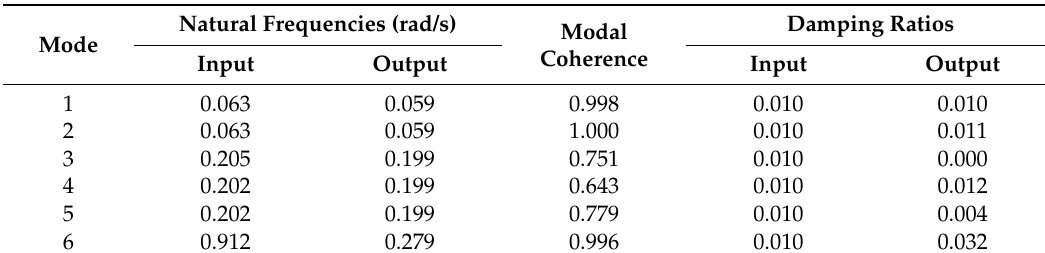
Table 10. Evaluation of FDD efficiency for the first damping ratio combination (case 1) in close to resonance wave